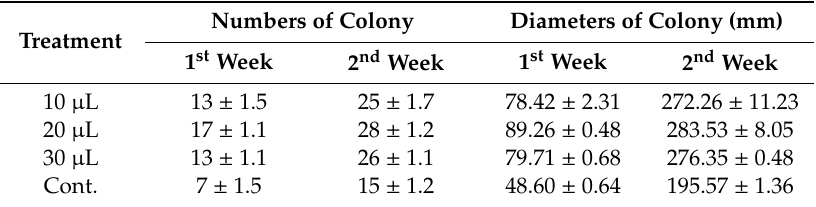
Table 2. Diameters and numbers of colonies of spermatogonial cells treated with three di ff erent concentrations of T. ammi oil after 2 weeks. Results are presented as mean ±